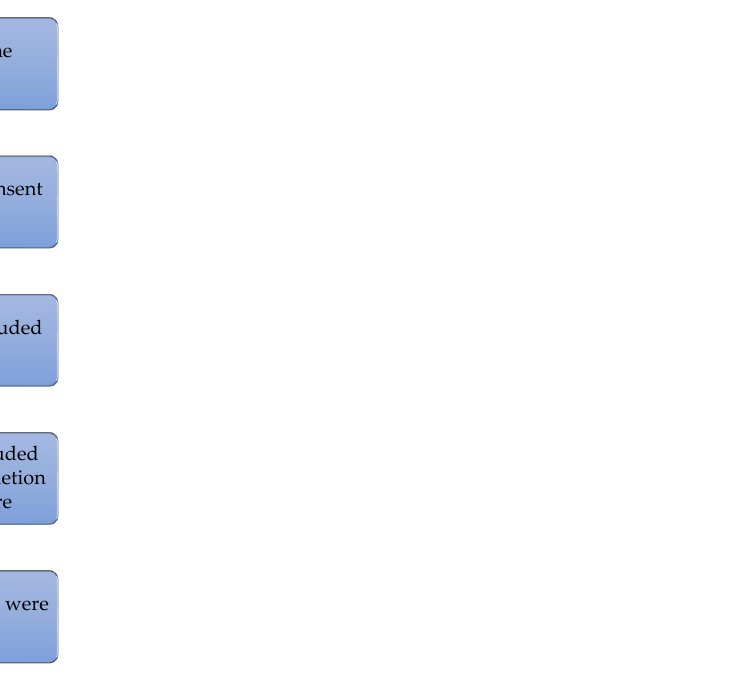
Figure 1. Diagram of the study group selection, taking into account the inclusion and exclusion criteria.